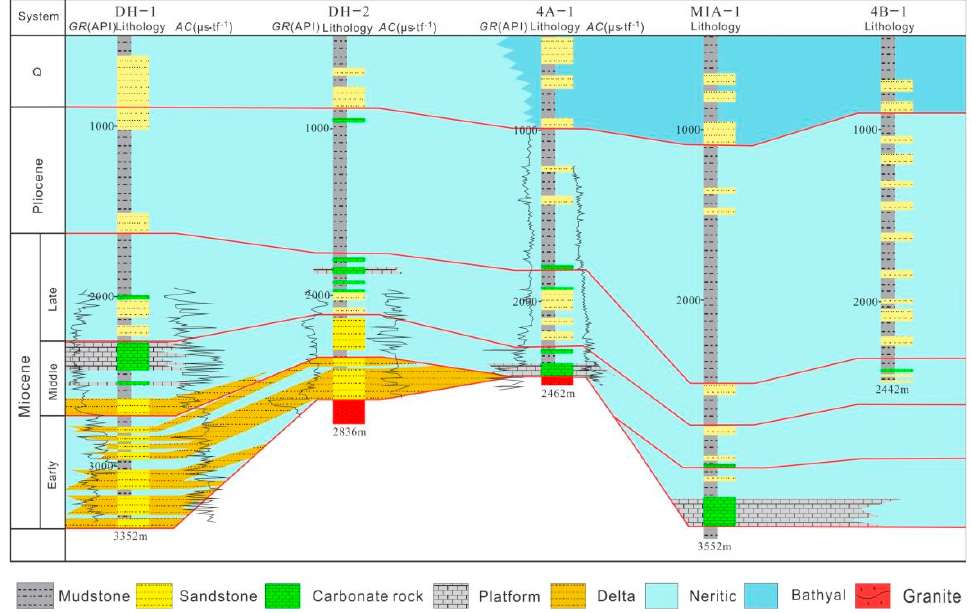
Figure 4. The associated stratigraphic columns of five wells in north of Wan’an Basin. Well location is shown in Figure 2.